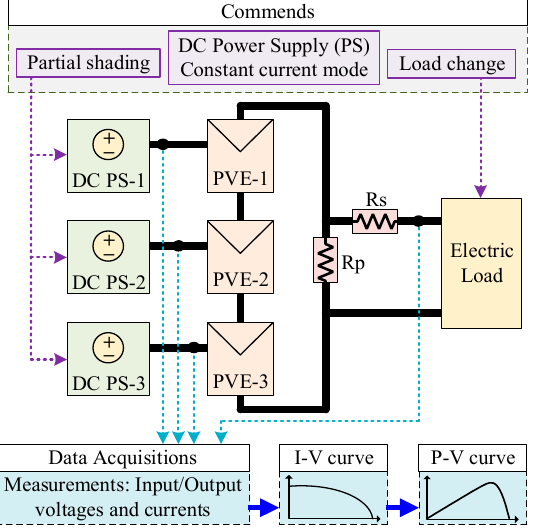
Figure 15. Block diagram for the experimental process with a series of multiple connected PVEs.